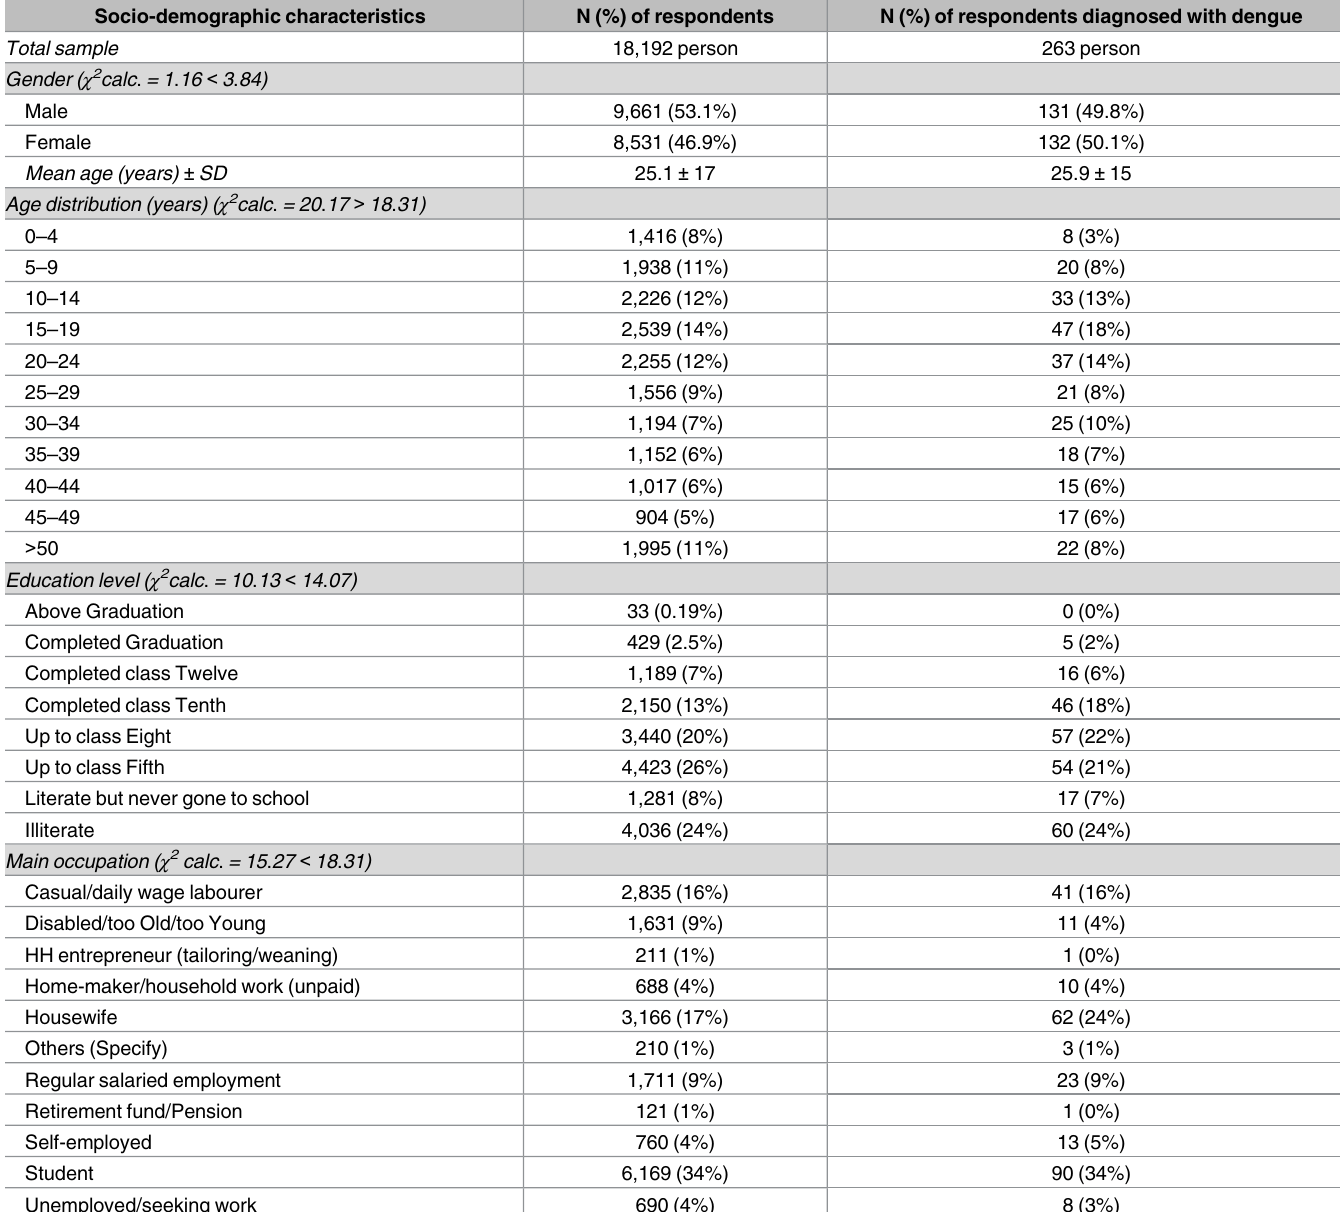
Table 1. Socio-demographic profile of the survey population (N = 18,192) and for dengue cases(N = 263). Socio-demographic